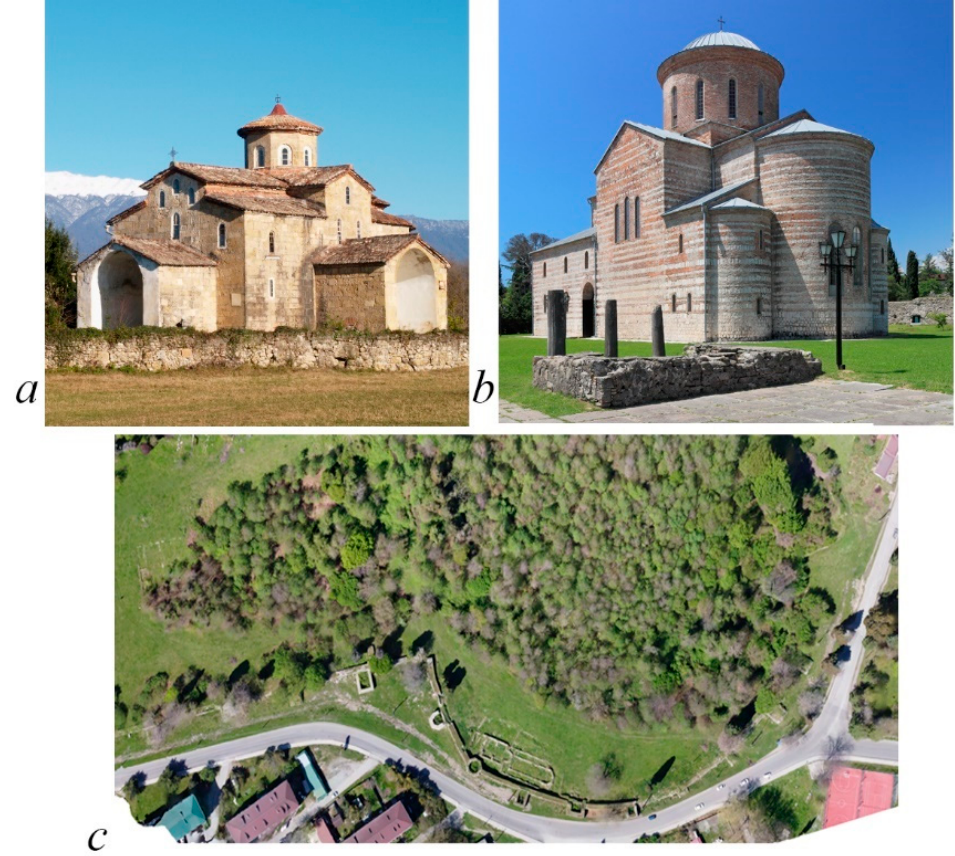
Figure 11. Lykhny temple ( а ), Pitsundsky cathedral ( b ), and fortress (orthophotoplan) ( c ).